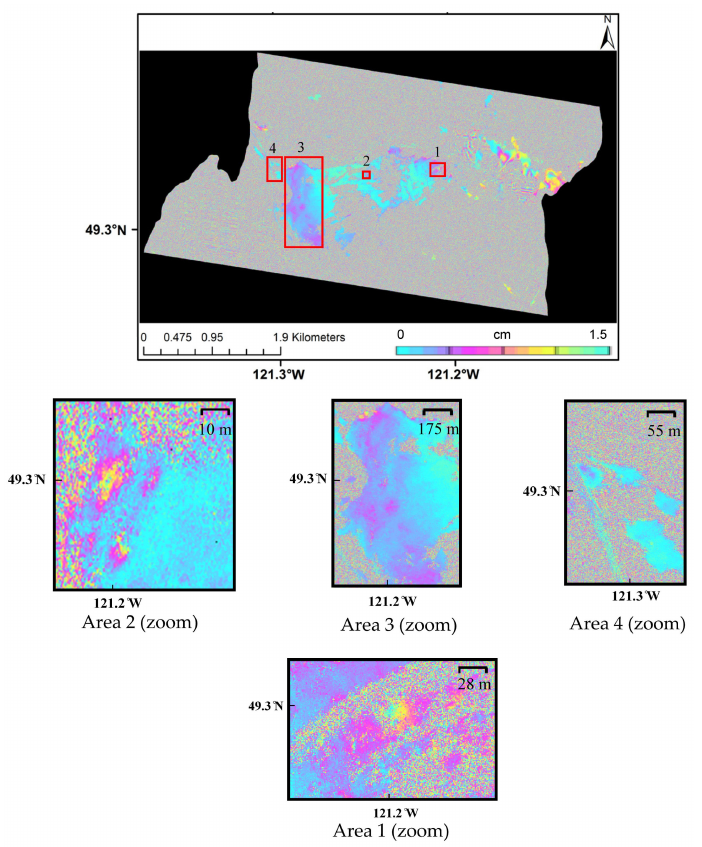
Figure 8. Hope Slide: Geocoded TSX interferogram (15 August 2015–23 September 2017). The four areas where deformation is observed are highlighted in red, and the zoom insets and the scales are also presented.